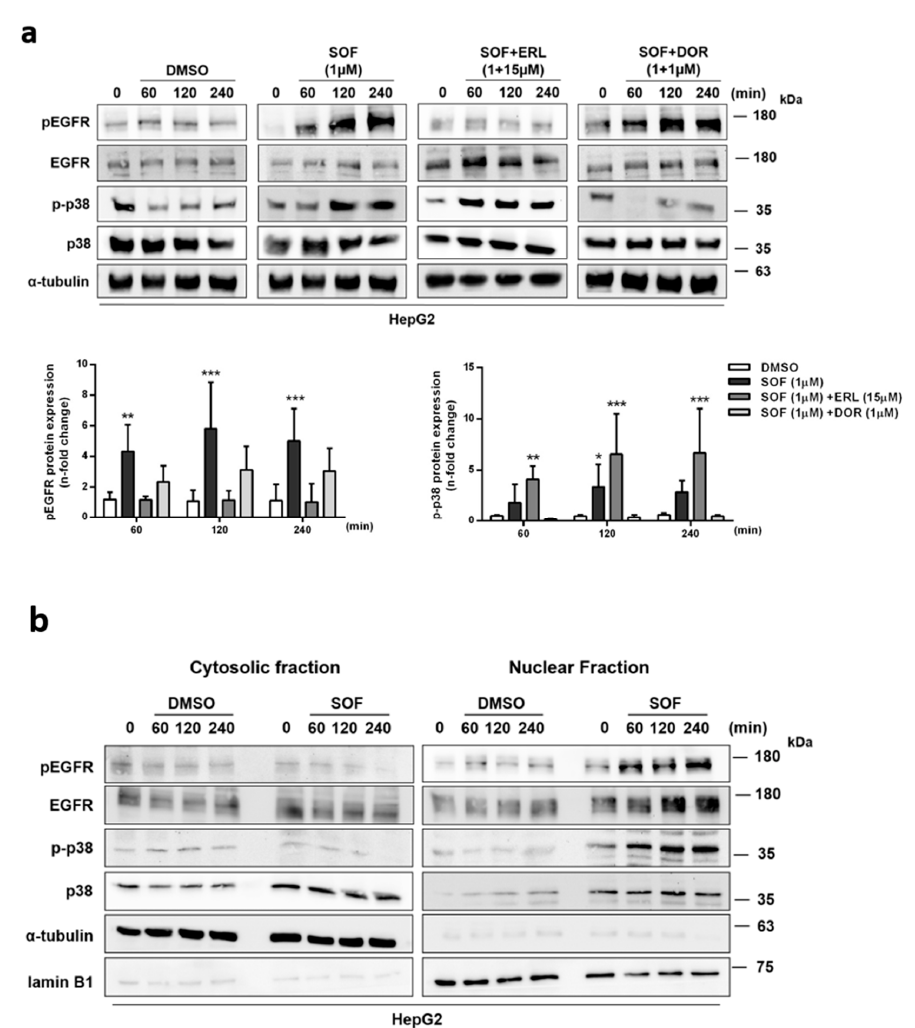
Figure 5. Regulation of EGFR phosphorylation and nuclear translocation during SOF treatment. ( a ) HepG2 cells were starved for 24 h and subsequently treated with SOF alone or in combination with pEGFR inhibitor (ERL) or p-p38 inhibitor (DOR). The protein level of target proteins was assessed at depicted time points by immunoblot analysis. One representative immunoblot is presented. Bar graphs display the relative quantification of pEGFR and p-p38 shown as fold change in relation to time point 0 (mean + s.d. from three independent experiments). Statistical significance was determined through two-way ANOVA (DMSO vs. treatment). * p ≤ 0.05; ** p ≤ 0.01; *** p ≤ 0.005. ( b ) The expression of target proteins in the cytoplasm and nucleus after SOF treatment at di ff erent time points was detected by immunoblot an lysis. One representative immunoblot of three (EGFR, pEGFR) and two (p-p38, p38) independent experiments is